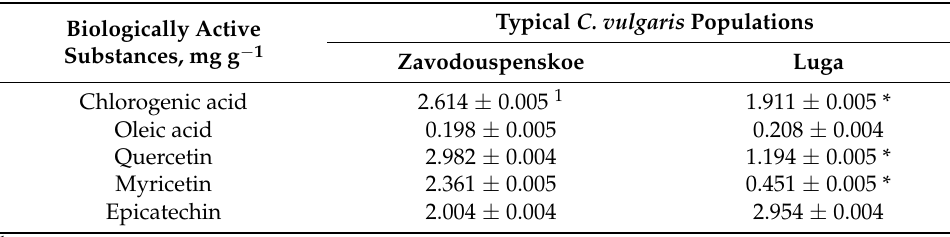
Table 3. Biochemical composition of C. vulgaris